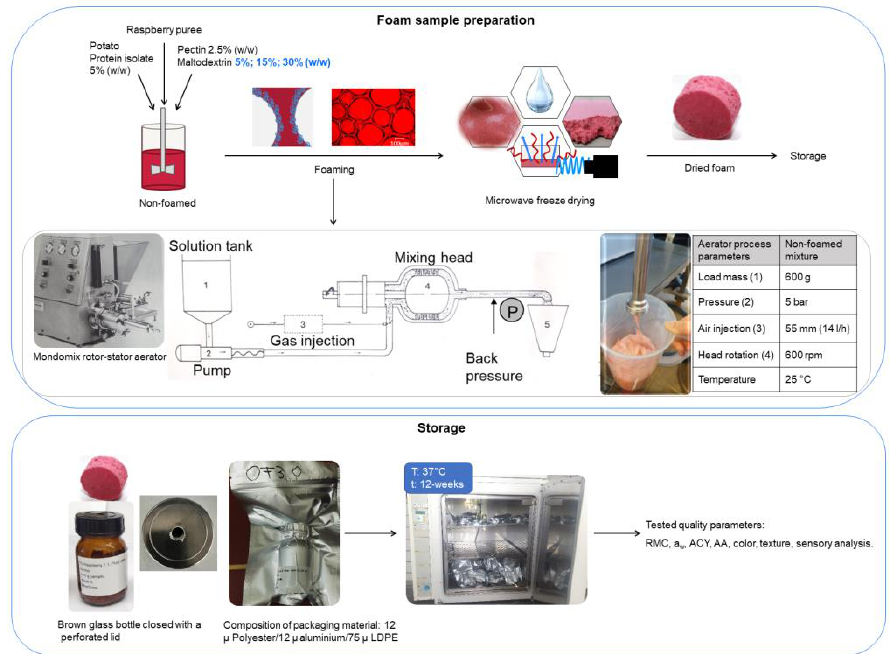
Figure 1. Schematic presentation of the experimental methodology with an aeration system (Haas Mondomix, Almere, The Netherlands).